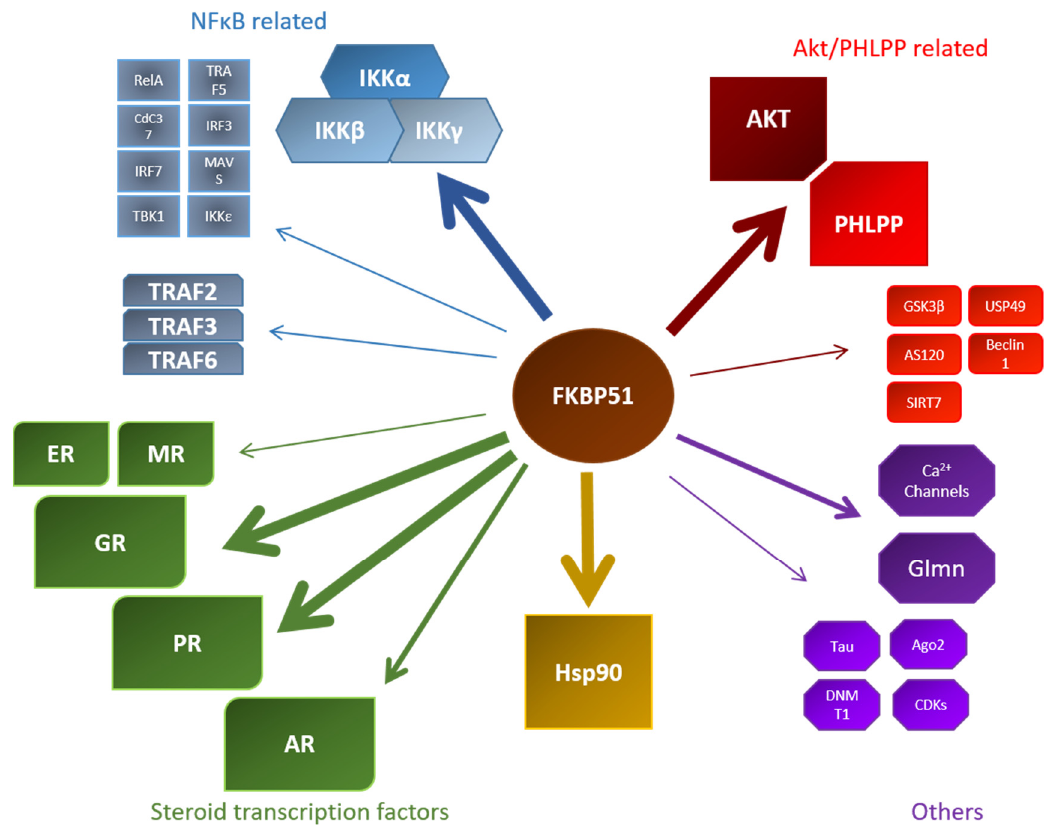
Figure 4. Overview of known FKBP51 interactors within their respective field of discovery. Stronger arrows indicate a larger data set of this specific interaction. MR: mineralocorticoid receptor; CDK: cyclin-dependent kinase; ER: estrogen receptor NF κ B: nuclear factor binding near the κ light-chain in B-cells; USP: ubiquitin-specific protease